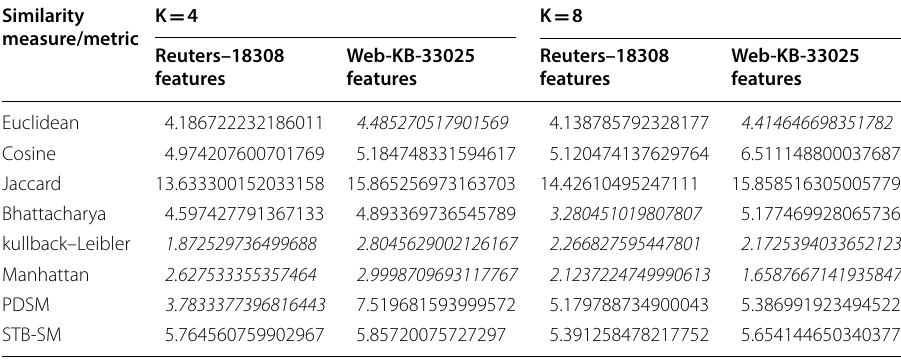
Italic values indicate the highest values that top measures achieved for corresponding evaluation metrics